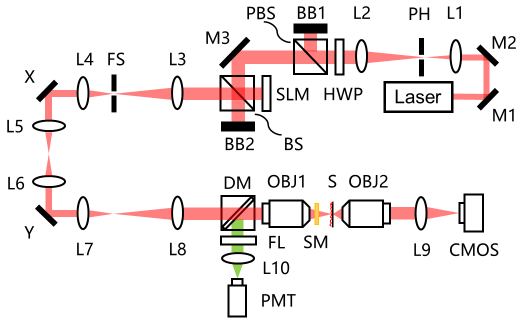
Fig. 1. Schematic diagram of the two-photon °uorescence microscope with multidither COAT: M 1 – M 3, Mirror; L 1 – L 10, Lens; PH, pinhole; HWP, half-wave plate; PBS, polarized beam splitter; BB1 – BB2, beam block; BS, non-polarizing beam splitter, 50:50 ( R – T ); SLM, spatial light modulator; FS, ¯eld stop; X & Y , galvanometer mirrors; DM, dichroic mirror; OBJ1, objective lens (UPLFLN 20X, Olympus); OBJ2, objective lens (UPLFLN 40X, Olympus); SM, scattering medium; S , sample; CMOS, complementary metal oxide semiconductor camera (DMK 23UV024, The Imaging Source); FL, ¯lter; PMT, photomultiplier